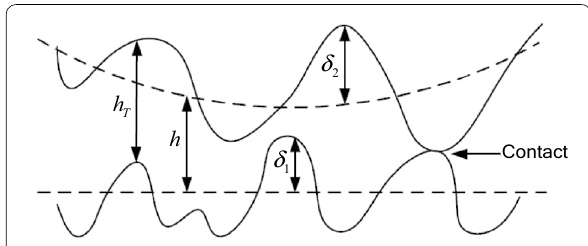
Figure 3 Diagram of two rough